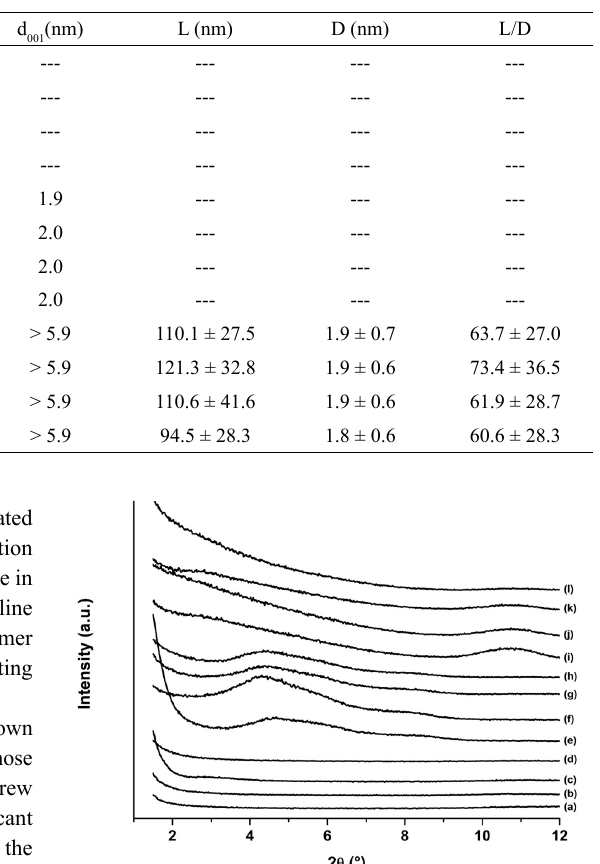
= degree of crystallinity), WAXD (θ = diffraction angle, d c